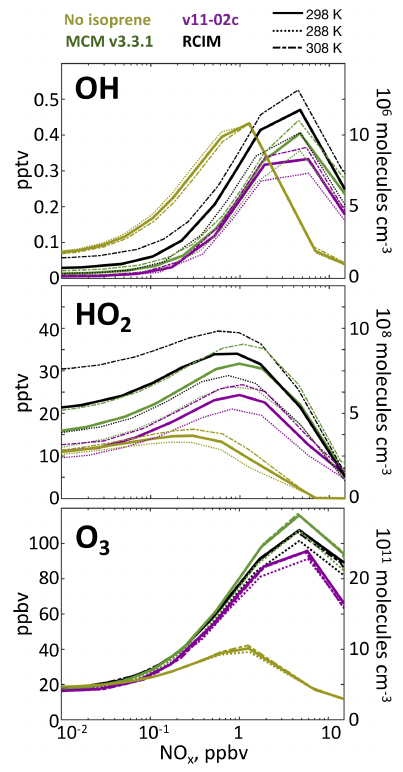
Figure 5. Effects of isoprene oxidation on OH, HO 2 , and ozone concentrations in a diurnal steady-state box model for clear-sky equatorial conditions as a function of NO x and temperature. The RCIM, MCM, and GEOS-Chem v11-02c mechanisms are com-